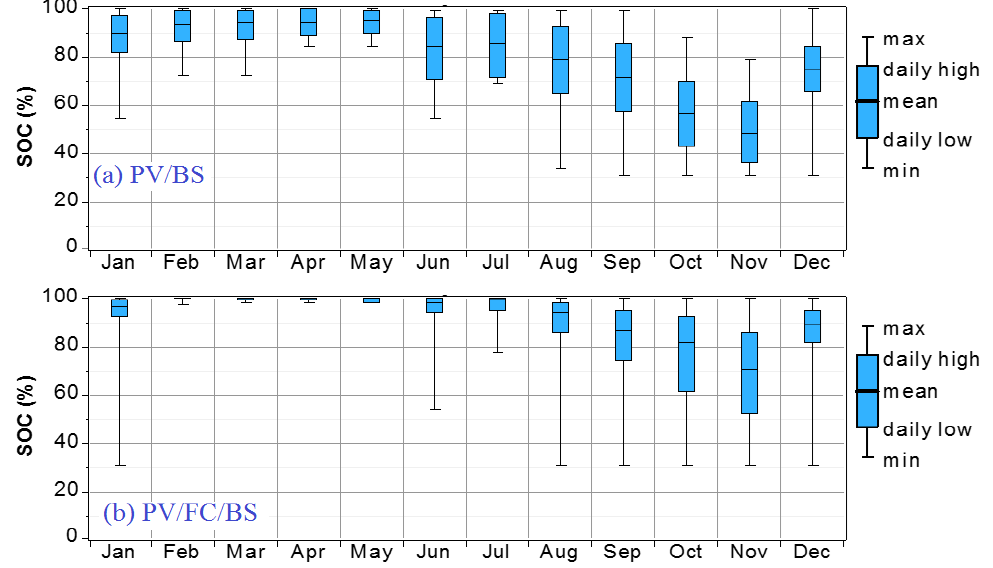
Figure 15. Monthly statistic of battery SOC.